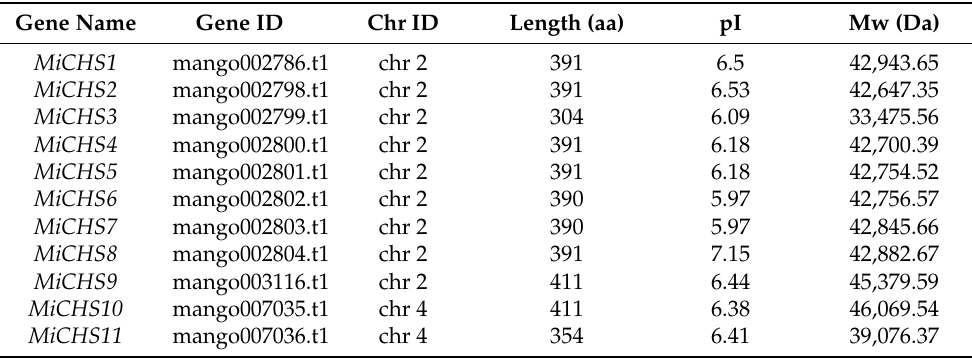
Table 1. Details of putative MiCHS